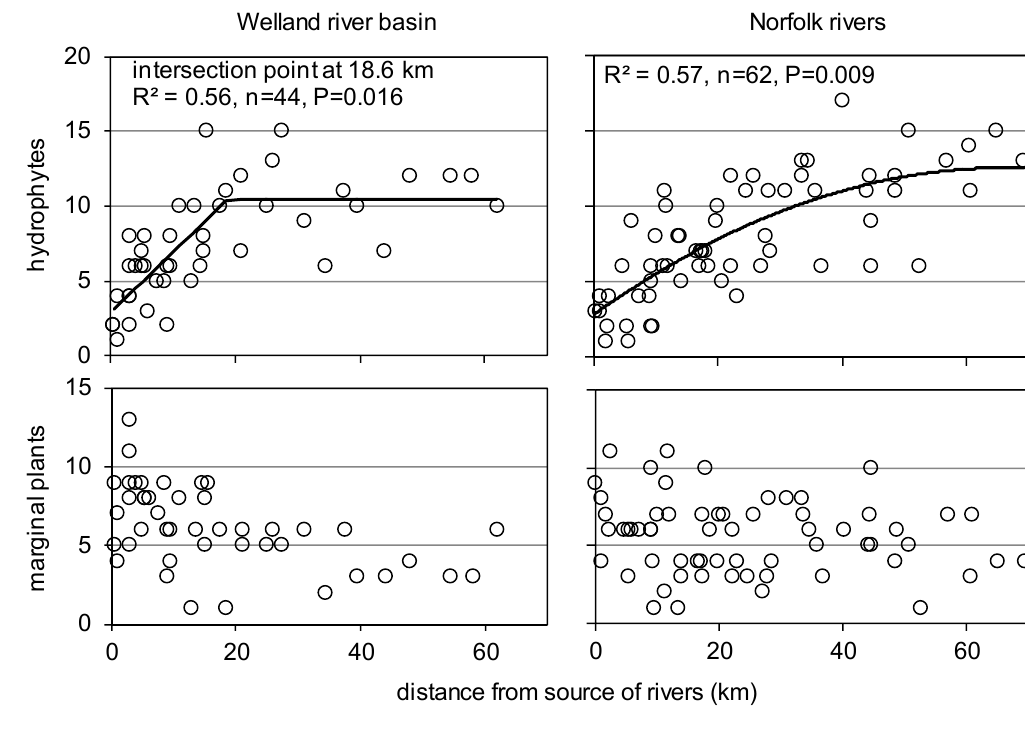
Figure 11. Changes in hydrophyte (square symbols, continuous regression line) and helophytes (triangle symbols, dashed regression line) species richness across river